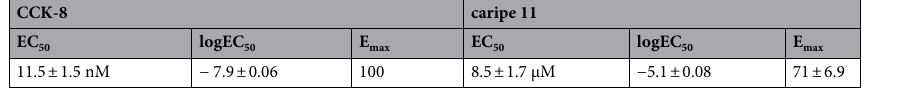
Table 2. Potency (EC 50 ) and maximum efficacy (E max ) of CCK-8 and caripe 11 at the CCK 2 R. Data are shown as mean ± SD based of three biological measurements (n =